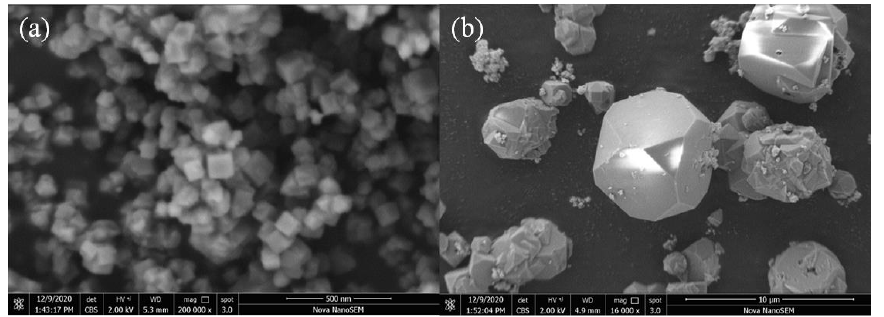
Figure 4. SEM images of UiO-66 with two crystal sizes (( a ) 150 nm, ( b ) 6 μ m). The FT-IR spectra of these two sizes of UiO-66 samples exhibited similar characteristic peaks, as shown in Figure S2. At higher frequencies, two intense bands around 1590 and 1395 cm − 1 associated with the OCO asymmetric and symmetric stretch vibrations in the carboxylate group in H 2 BDC are clearly shown for the two sizes of UiO-66 samples. At lower frequencies, the bands around 810 and 710 cm − 1 are mixed with the C–H vibra- tion, OH bend, and OCO bend in H 2 BDC. The band around 556 cm −1 belongs to the Zr – (OC) asymmetric stretch [22]. Thus, the structures of two sizes of UiO-66 were similar and retained in accordance with the XRD analysis.